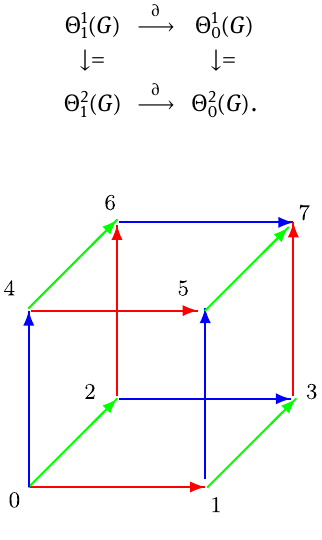
Figure 3: The proper edge - colored digraph